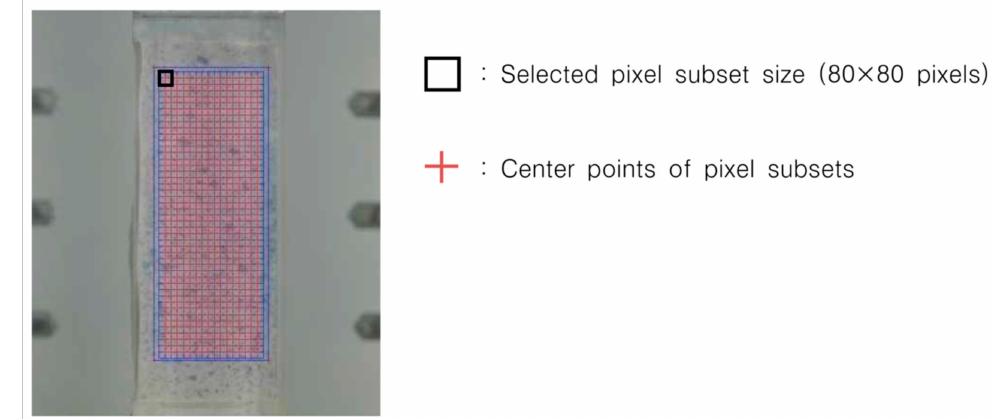
Figure 6. Selected pixel subsets and center points for the PIV technique.